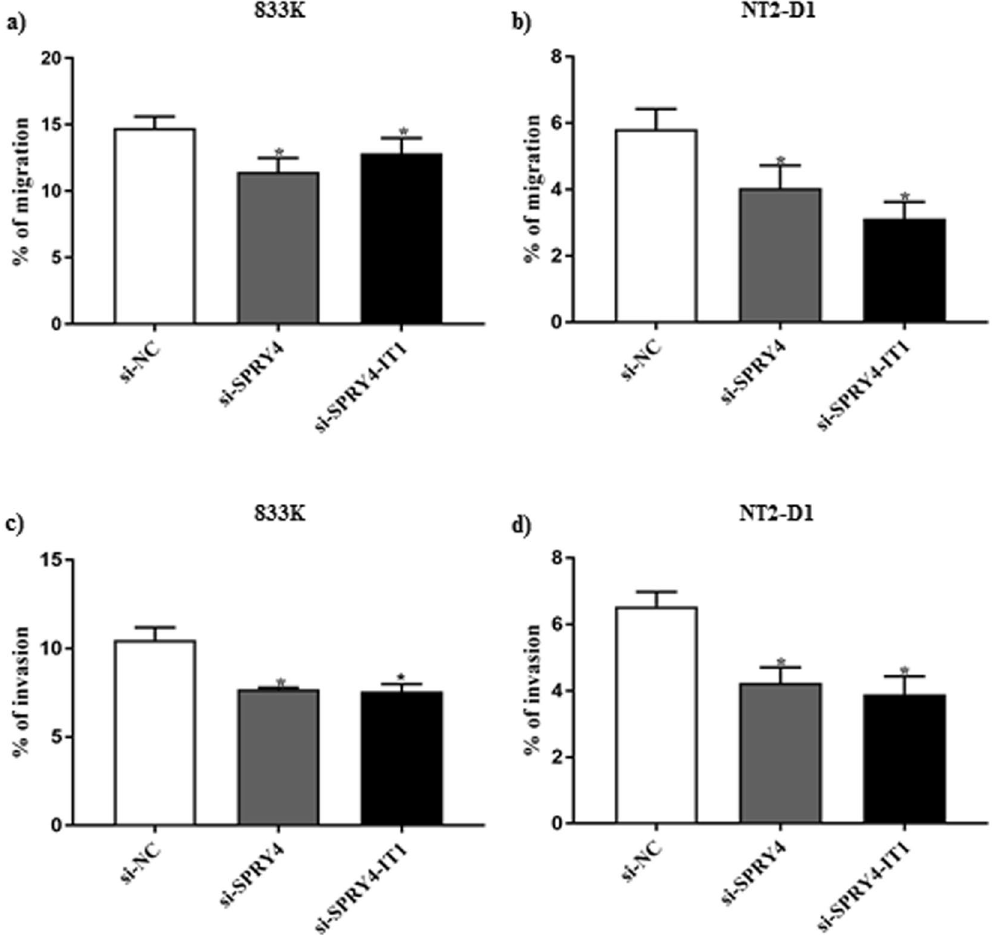
Figure 4. Cell migration and invasion after knockdown of SPRY4 and SPRY4-IT1 . Knockdown of both SPRY4 and SPRY4-IT1 reduced the cell migration and cell invasion both in 833 K ( a , c ) and NT2-D1 ( b , d ) cells respectively. Percentage of cell migration and invasion was analysed by converting relative fluorescence units (RFU) into a number of cells. The experiments were repeated at least three times, and a representative experiment is shown here. t -test: Control vs siRNA, mean ± SD, statistical significance p <